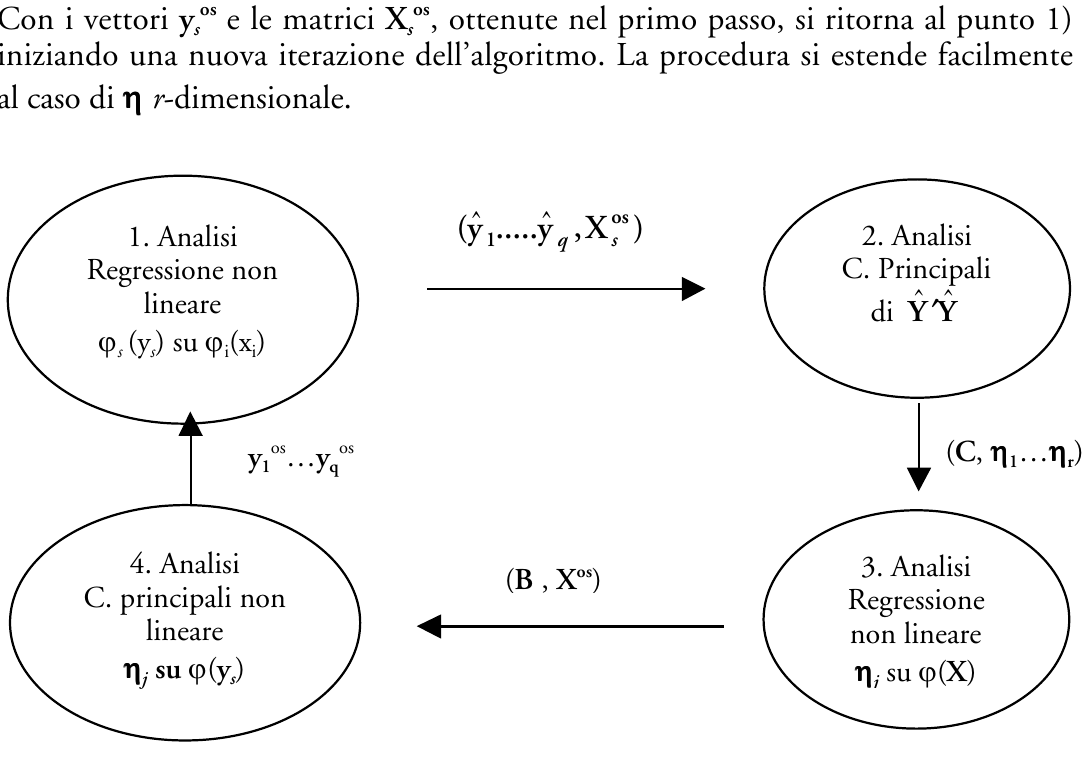
Figura 4 – Diagramma di flusso dell’algoritmo: l’ i -esima iterazione è composta di 4 stadi (evidenziati nelle ellissi); le variabili presso le frecce costituiscono gli output di ogni stadio. ϕ (.) è la trasforma- zione ottimale per la variabile in